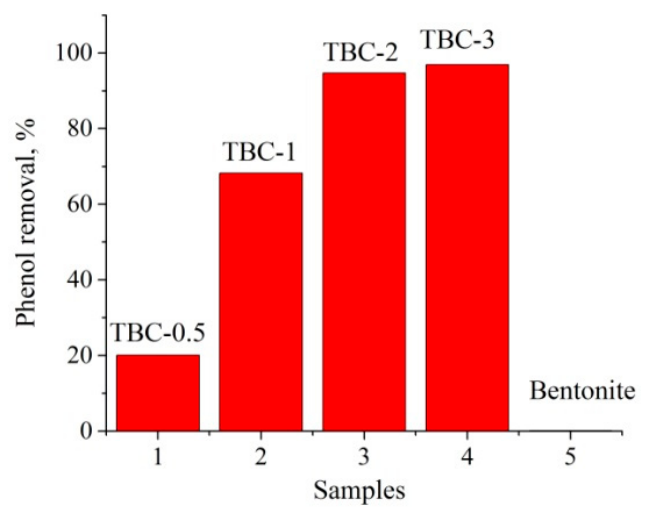
Figure 7. Comparison of adsorption isotherms of MB on the biochars: 1—TC (control), 2—TBC-3, 3—TBC-2, 4—TBC-1, 5—TBC-0.5 ( a ), and the effect of contact time and pH of the solution of MB on the removal by TBC-0.5 ( C 0 = 20 mg/L, m = 10 mg, V s = 5 mL) ( b ).